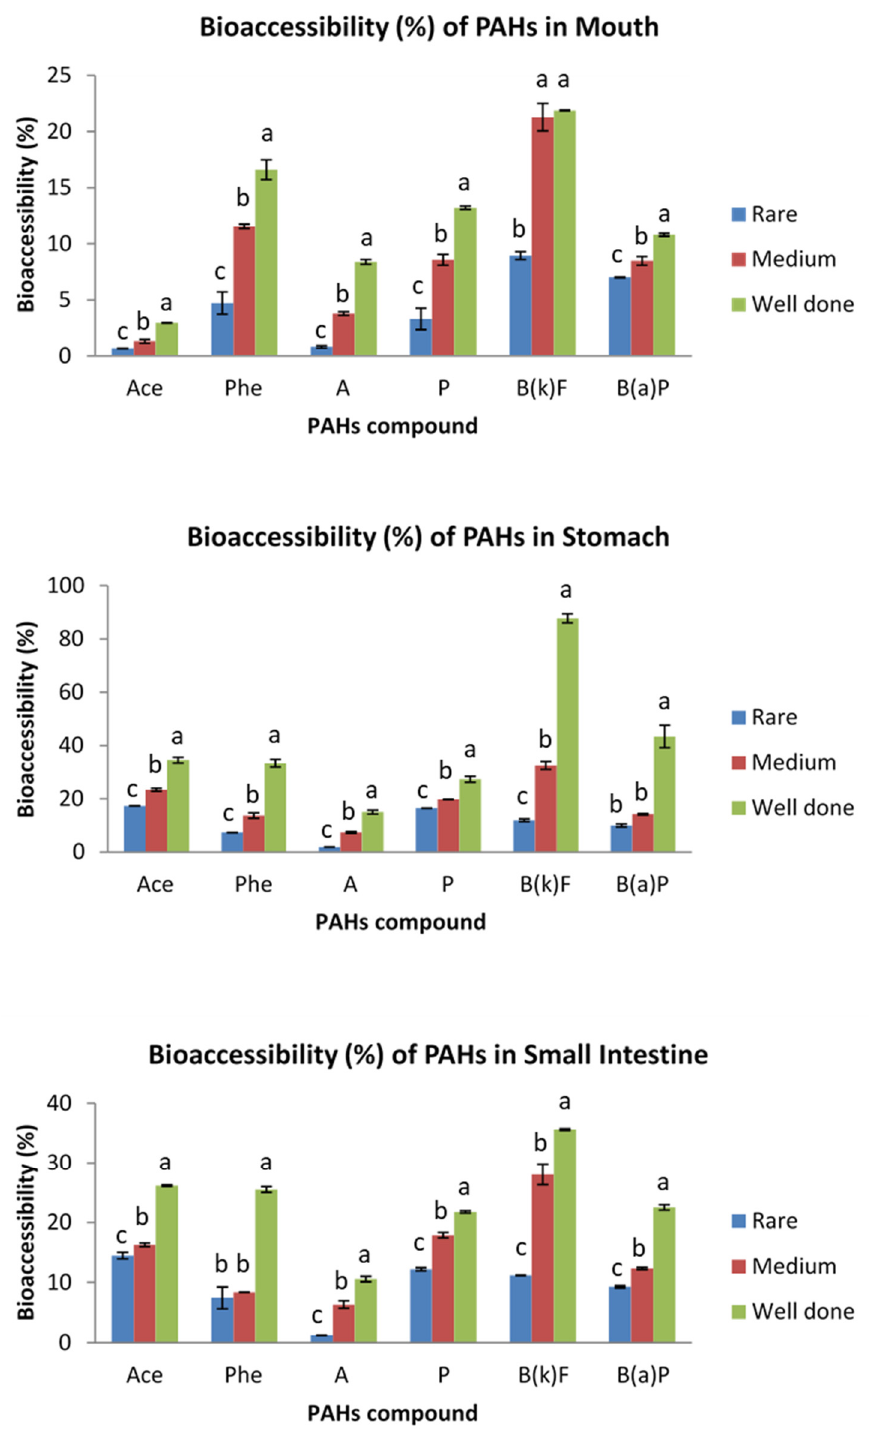
Figure 5. Bioaccessibility (%) of PAHs in grilled chicken at different degrees of doneness in mouth, stomach and small intestine. Different letter indicates significant differences in bioavailability of PAHs in grilled chicken of different doneness. Ace, acenaphthene; Phe, phenanthrene; A, anthracene; P, pyrene; B(k)F, benzo(k)fluoranthene; B(a)P, benzo(a)pyrene.